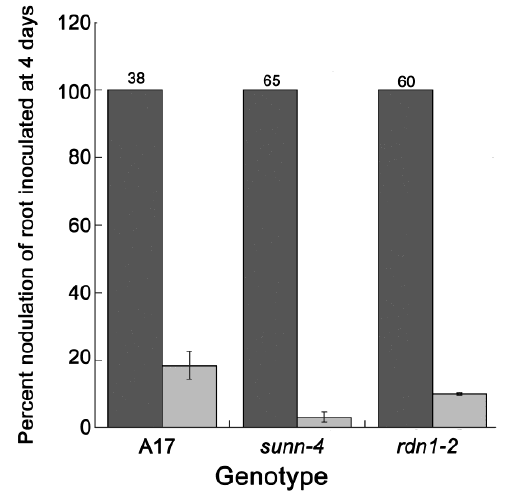
Figure 5. AON mutants and wild type plants suppress nodulation after long periods of water only treatment of the first root. Dark grey bars represent nodulation on the second root after four days of water treatment prior to inoculation and is set to 100% (actual mean on top of bar); light grey indicates mean percent reduction in nodulation on the second root after 11 days treatment of the first root prior to inoculation. Bars indicate standard error of the percentage means calculated by Taylor expansion. n = 9–16 plants per genotype per